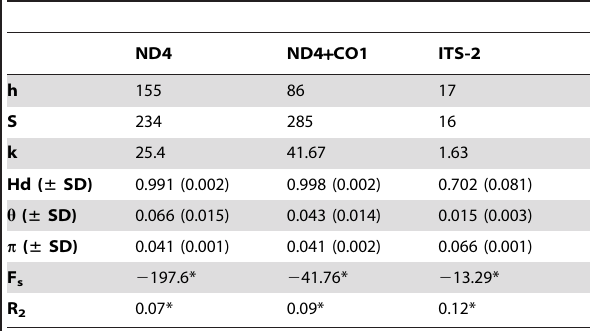
Table 3. Diversity and neutrality estimates for ND4, combined ND4 and CO1 genes, and partial ITS-2 of Colombian T. dimidiata .